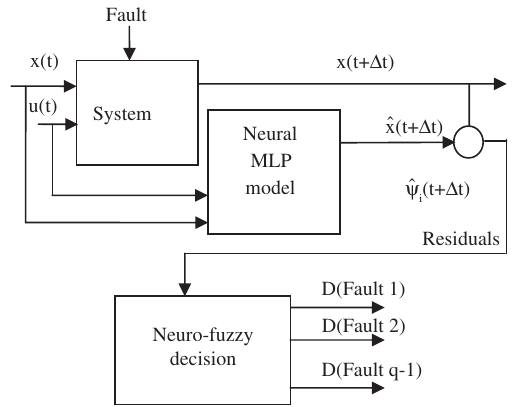
Figure 1. Residual Generation and Neuro-fuzzy Decision.